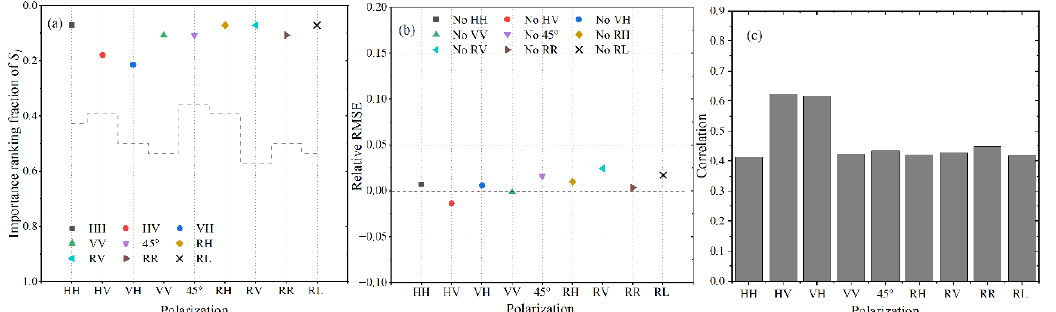
Figure 26. The importance of 20 CWAVE spectral parameters to SWH retrieval from ( a ) single-polarization models, and ( b ) combined-polarization models.